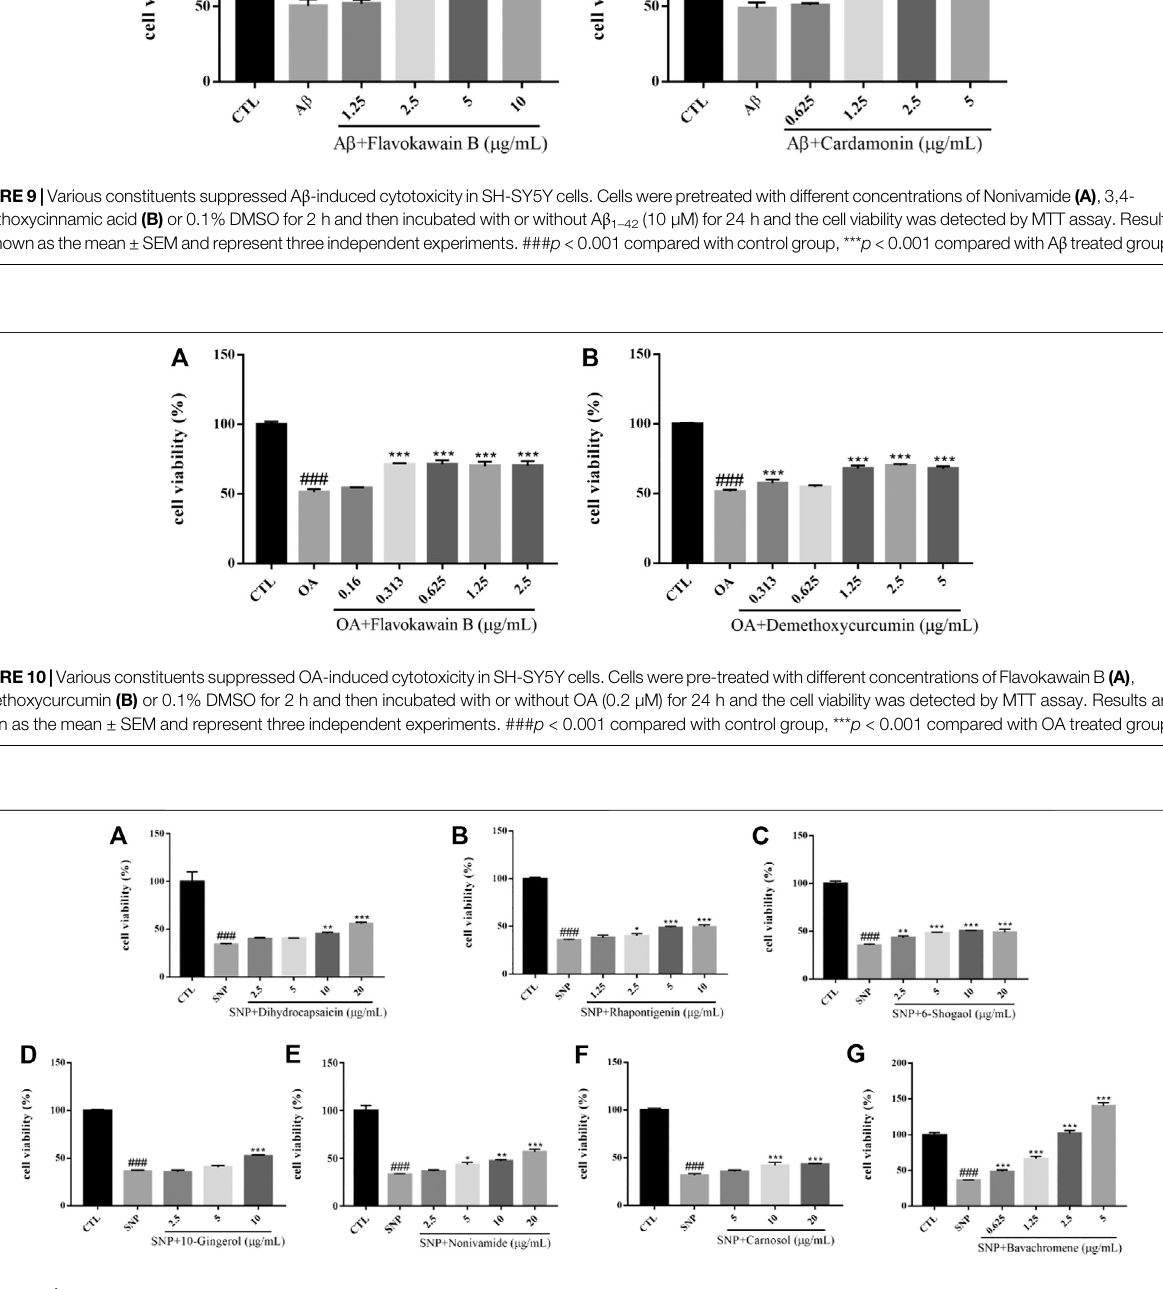
Frontiers in Pharmacology |